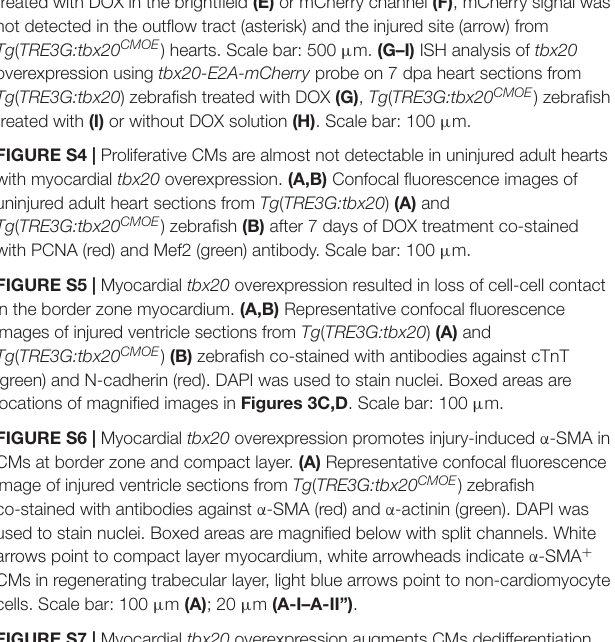
TABLE S3 | FPKM values of differentially expressed genes in control and myocardial tbx20 overexpressing hearts at 7 dpa. TABLE S4 | Primers used in this